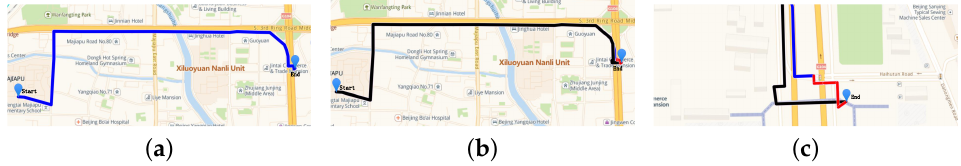
Figure 7. Example of close distance between start and end. ( a ) Route when the traffic is smooth; ( b ) The Congestion close to the end; ( c ) Detail of congestion near the end point in ( b